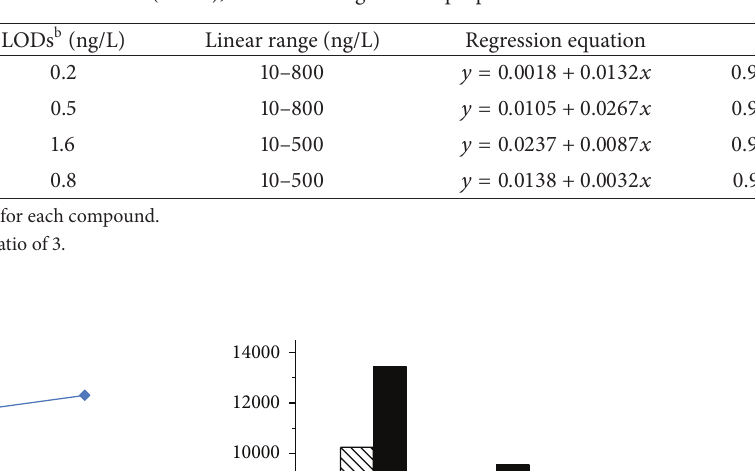
Table 4: Precisions (RSD), limits of detection (LODs), and linear ranges of the proposed method.